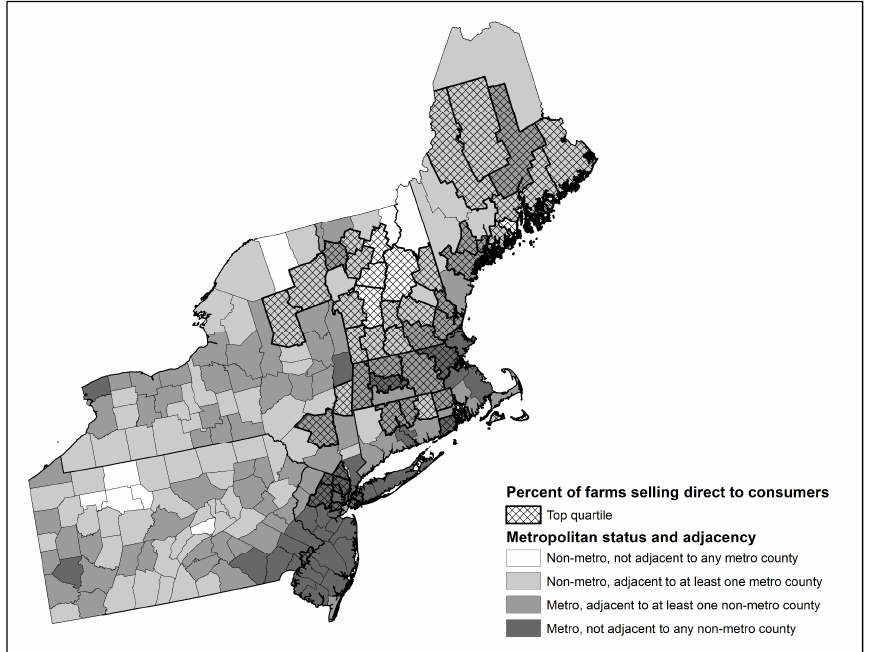
Figure 2. Top-quartile of Percent of Farms Selling Direct and Metropolitan